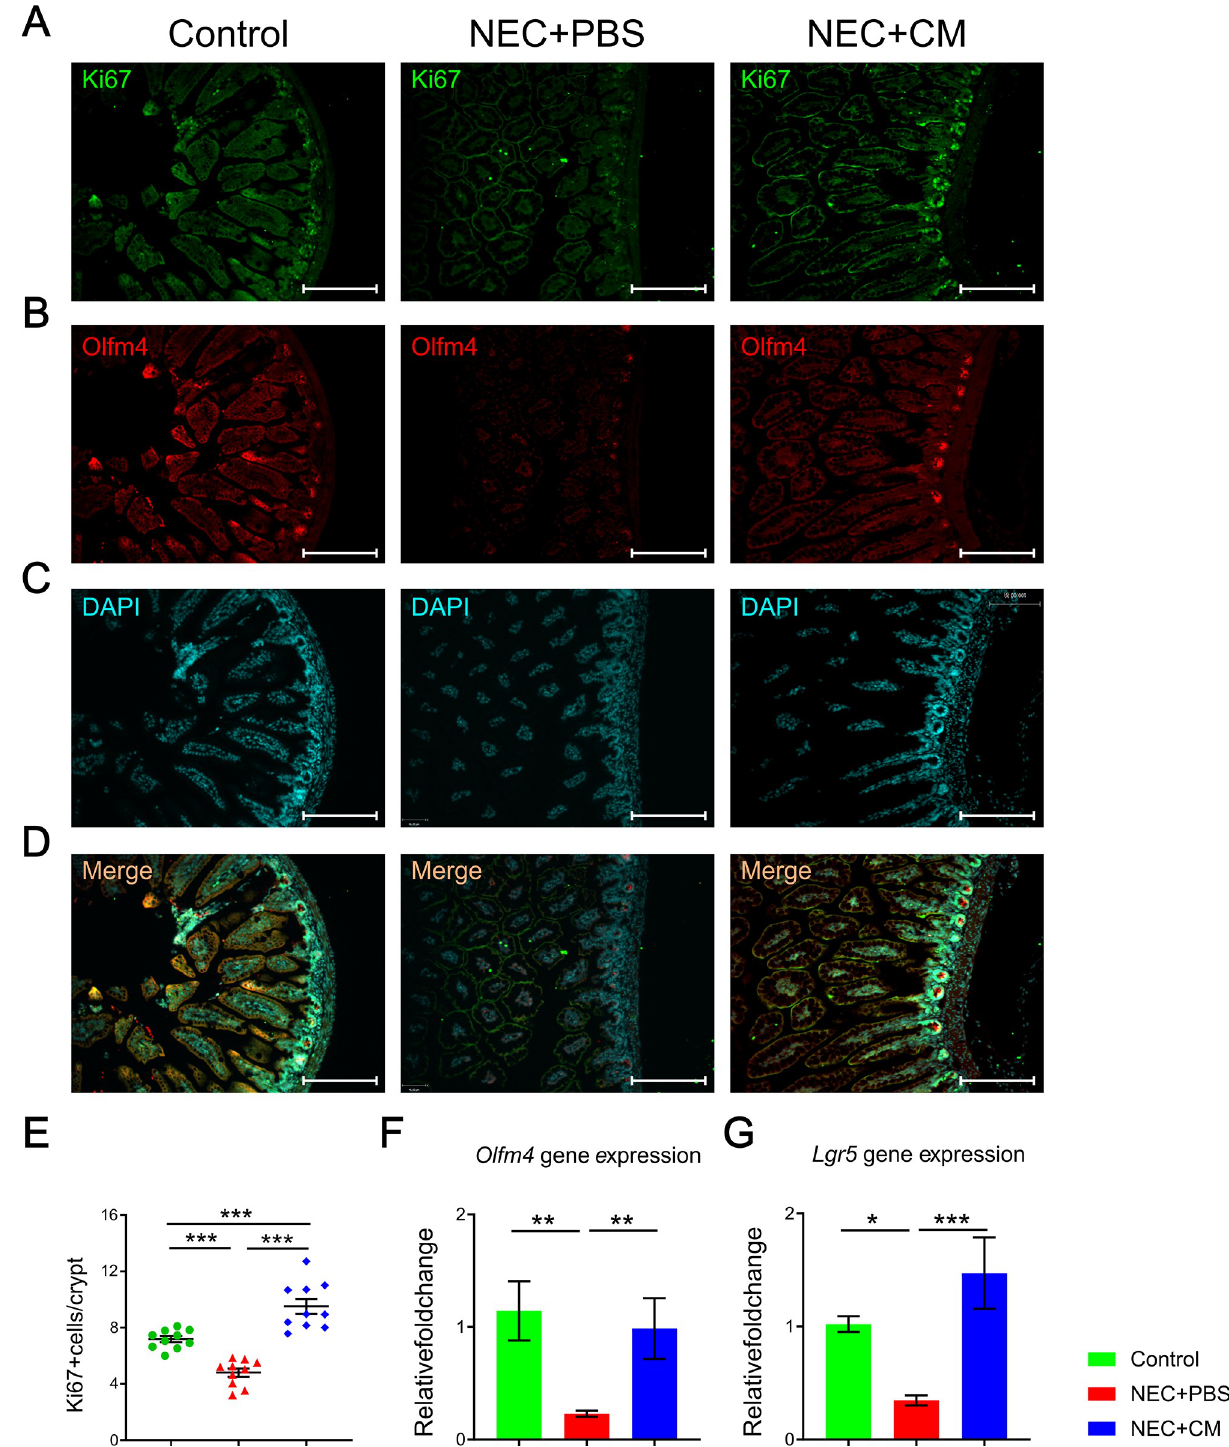
Fig 3. Intestinal proliferation and regeneration. Representative immunofluorescent histomicrographs of the terminal ileum from the control, NEC +PBS, and NEC+CM groups, showing expression of (A) KI67, (B) OLFM4, (C) DAPI staining denoting the nuclei for each respective group, and (D) merging the 3 stains with yellow staining denoting positive KI67 and DAPI overlap. Relative quantitative expression for (E) KI67, (F) Olfm4 , and (G) Lgr5 in the 3 groups. Data are presented as mean ± standard error, with significance of group comparisons based on one-way ANOVA and Tukey post- hoc tests. n = 10 for each group, � p < 0.05, �� p < 0.01, and ��� p < 0.001.